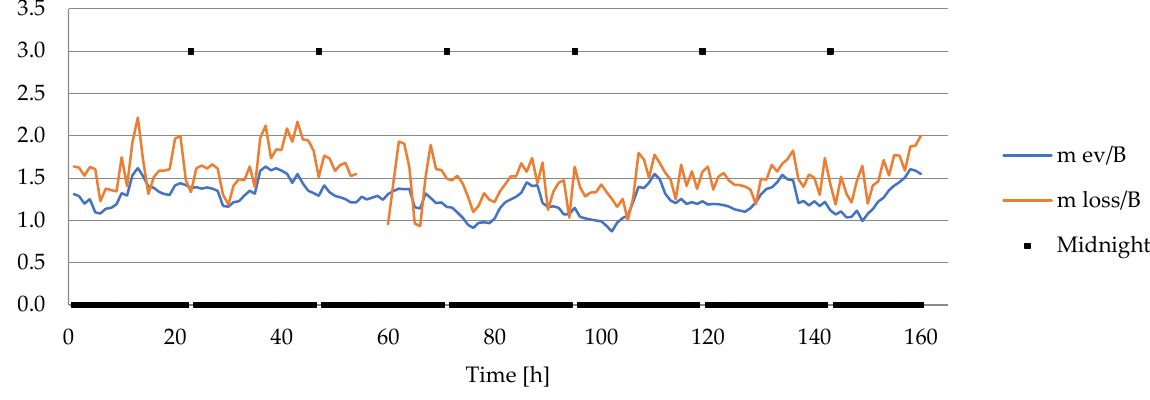
. . m loss and evaporative loss m ev related to the instantaneous power of power unit 5 Figure 8. Water loss Figure 8. Water loss 𝑚̇ 𝑙𝑜𝑠𝑠 and evaporative loss 𝑚̇ 𝑒𝑣 related to the instantaneous power of power unit 5 [ 𝑡ons/MWh ].